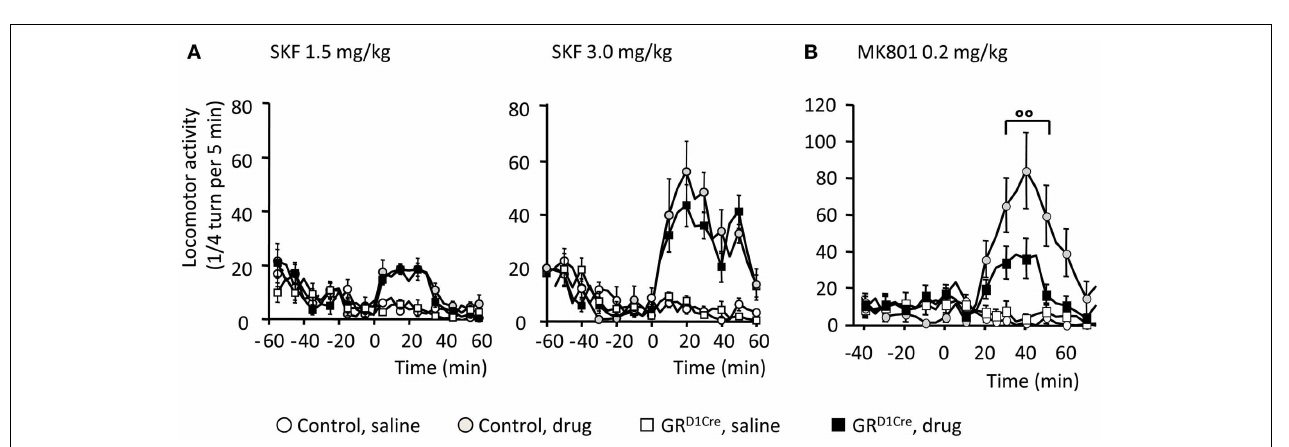
and GR D1Cre mice. CPP induced by amphetamine (1mg/kg) differed in control and GR D1Cre mice. Interaction Drug × Genotype F ( 1 , 39 ) = 4 . 5, P < 0 . 05. (C) Amphetamine (1mg/kg)-induced comparable CPP in both control and GR DATCre mice. No interaction Drug × Genotype F ( 1 , 35 ) = 1 . 1, P > 0 . 05. ns: non-significant, ∗ P < 0 . 05; ∗∗ P < 0 . 01; control vs. mutant: ◦◦ P < 0 . 01. n = 8–12 mice per group.